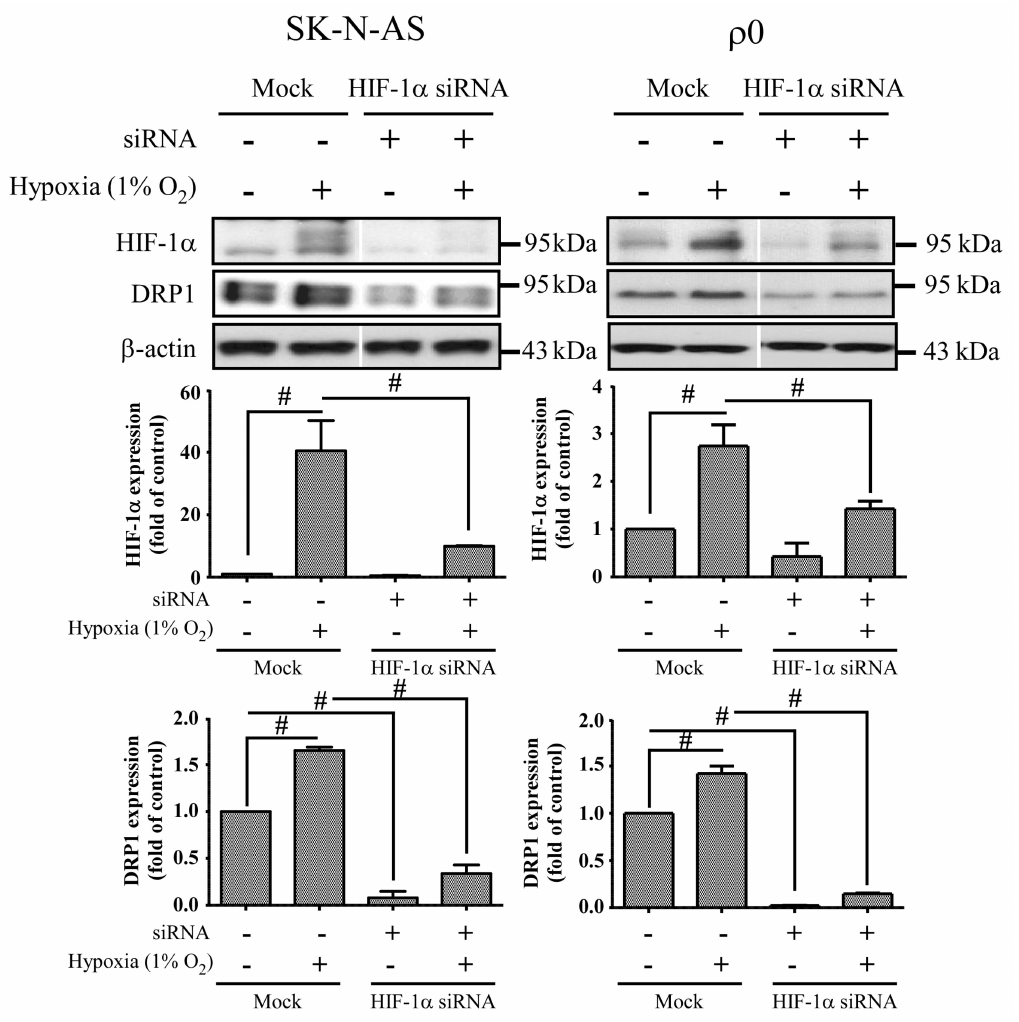
Figure 7. The effect of HIF-1 α siRNA. Cells were transiently transfected with siRNA targeted for HIF-1 α (HIF-1 α siRNA) or non-specific siRNA (Mock) for 24 h, and then incubated in normoxia or 1% O 2 for 4 h. The expression of HIF-1 α , DRP1 and β -actin proteins was revealed by Western blot analysis, and the quantification analyses are shown below. β -Actin was used as a loading control. The results are shown as mean ± SD of at least three experiments. # Represented p < 0.005 when compared to normoxic Mock condition was determined using the one-way